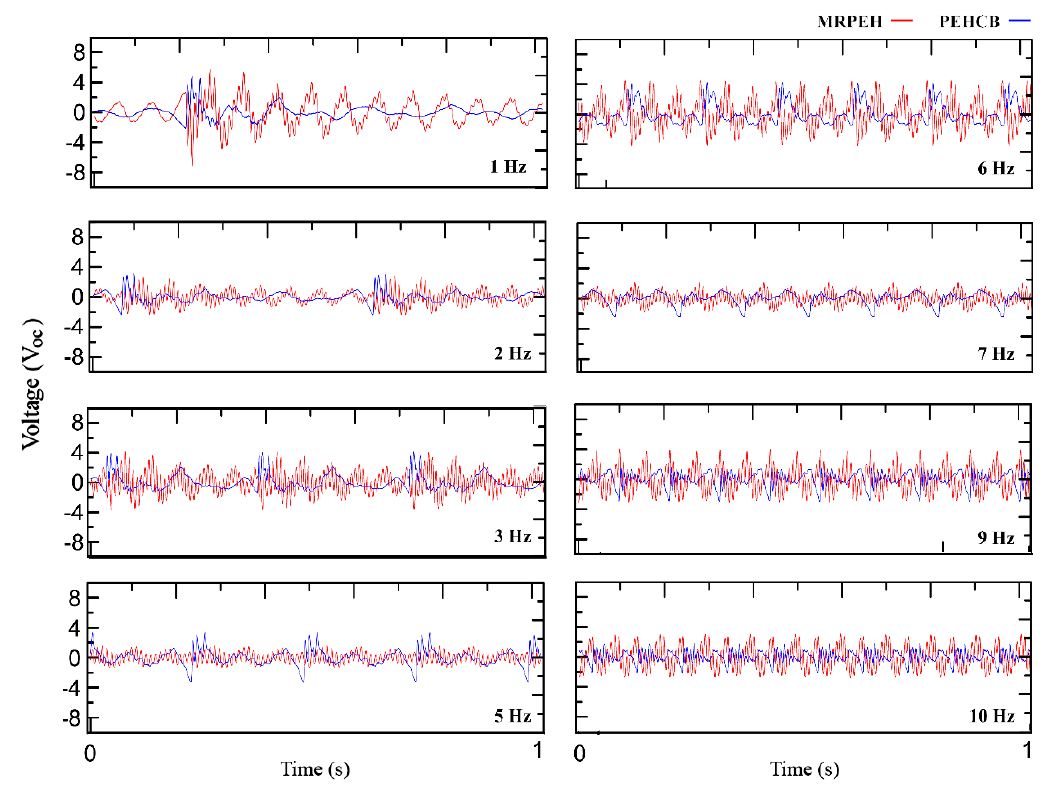
Figure 9. Comparison of open circuit voltage harvested from MRPEH and conventional PEHCB at nonresonance frequencies below 10 Hz.